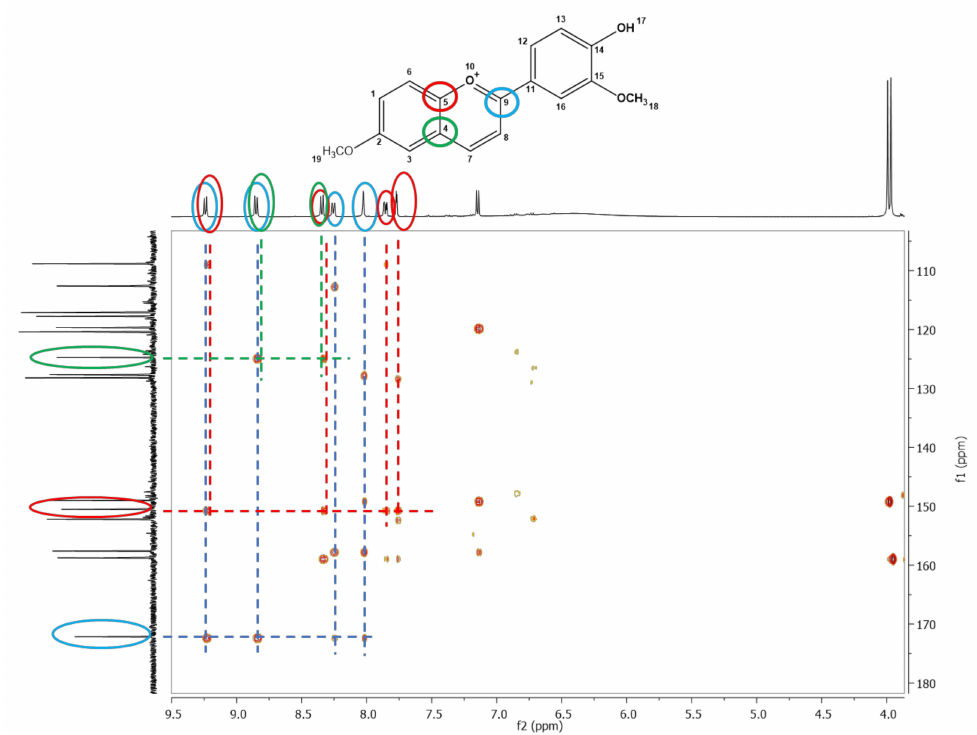
Figure 2. The 1 H- 13 C-HMBC spectrum of 6-methoxy-4 (cid:48) -hydroxy-3 (cid:48) -methoxyflavylium hydrogensul- fate (compound 5 )-the remote couplings between carbon atoms and protons are depicted by different coloured circles, green–C4 with H6 and H8, red–C5 with H3, H6 and H7, blue–C9 with H7, H8, H12 and